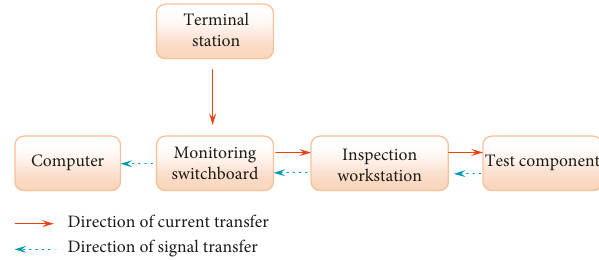
Figure 8: Signal transfer schemes of the test